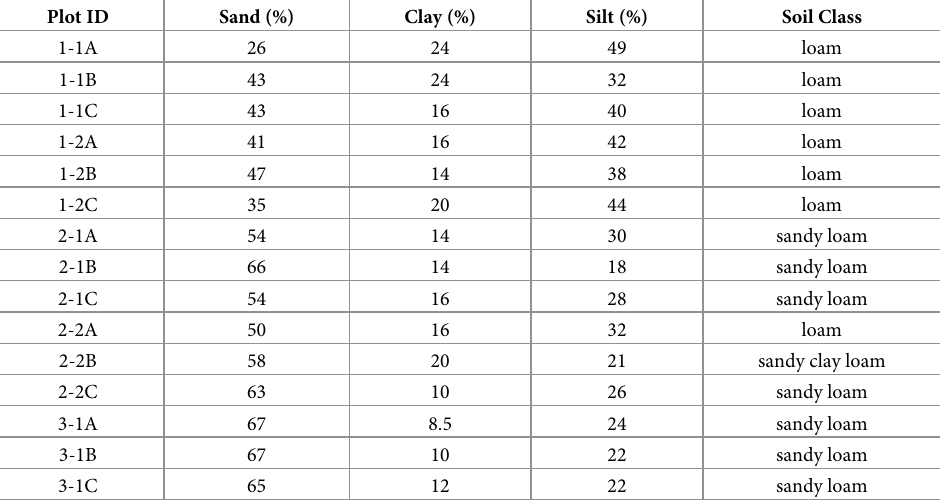
Table 1. Soil texture classes and sand/silt/clay content for each exclosure. Ranches are the first letter in the ID (i.e., B, P, or S), site is the number in the second position, and the third letter corresponds to an individual plot (i.e., A, B, or